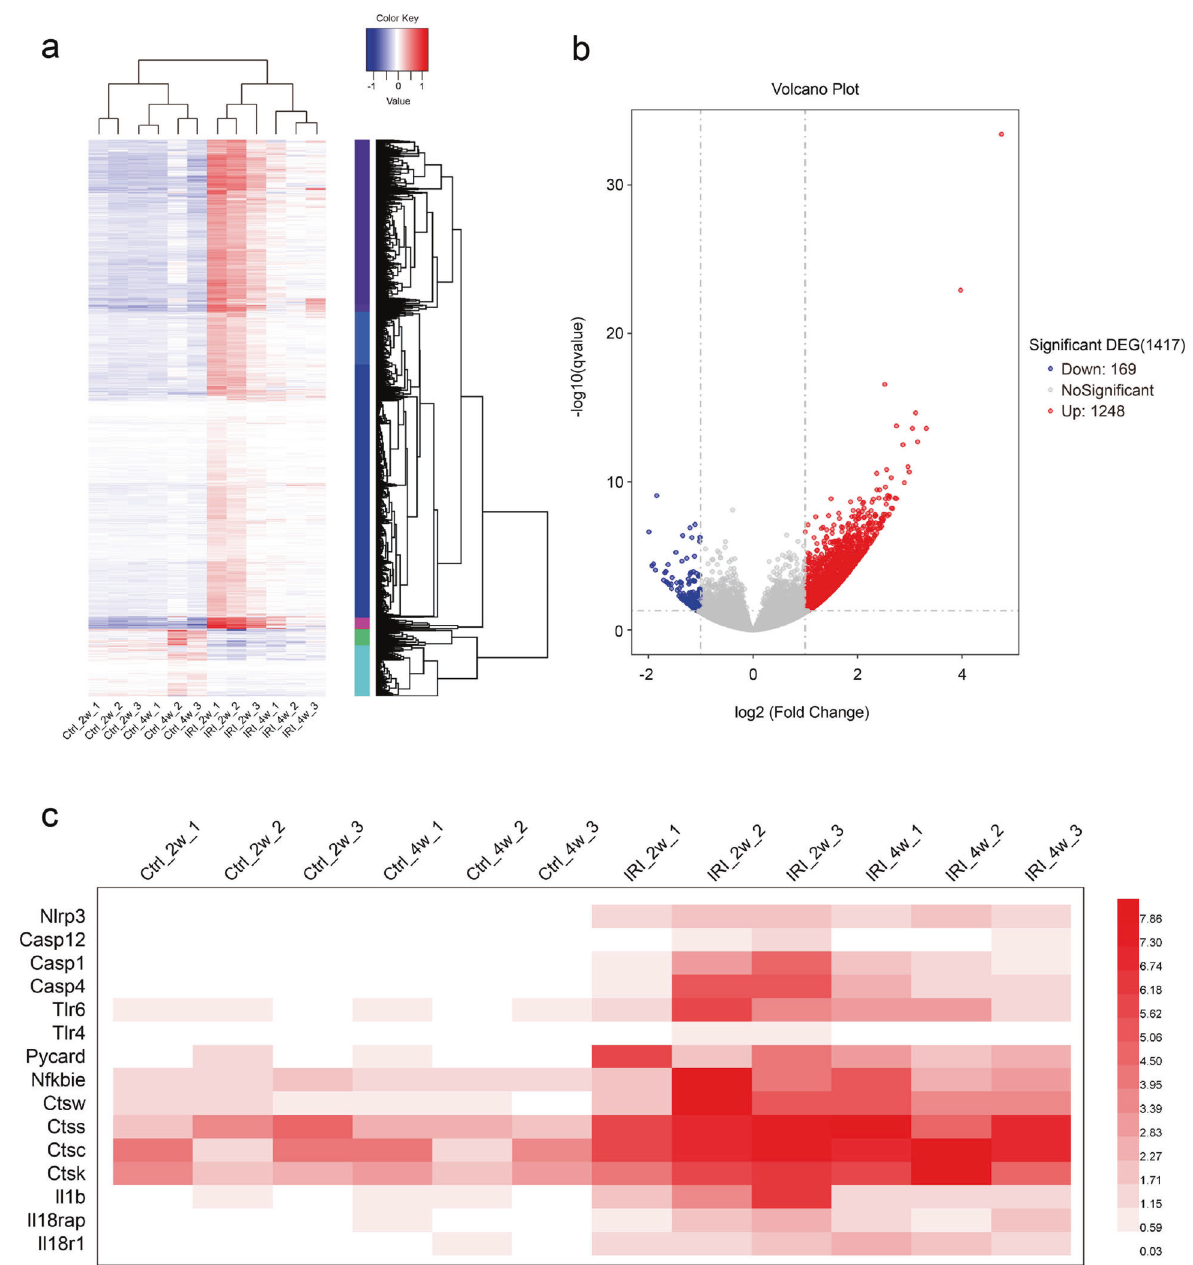
Fig. 4 RNA-sequencing of renal NLRP3 signaling following AKI. a Heatmap of 1417 DEGs screened by limma package. Red areas represent highly expressed genes and blue areas represent lowly expressed genes in 2 or 4 weeks post-IRI group, compared with sham controls. b Volcano plot analysis identi fi es DEGs. Red dots represent upregulated genes and green dots represent downregulated genes in 2 or 4 weeks post-IRI group, compared with sham controls. c The expression of NLRP3 signaling-associated genes NLRP3 signaling-associated genes in sham control or IRI groups. DEG differentially expressed gene, IRI Ischemia/reperfusion